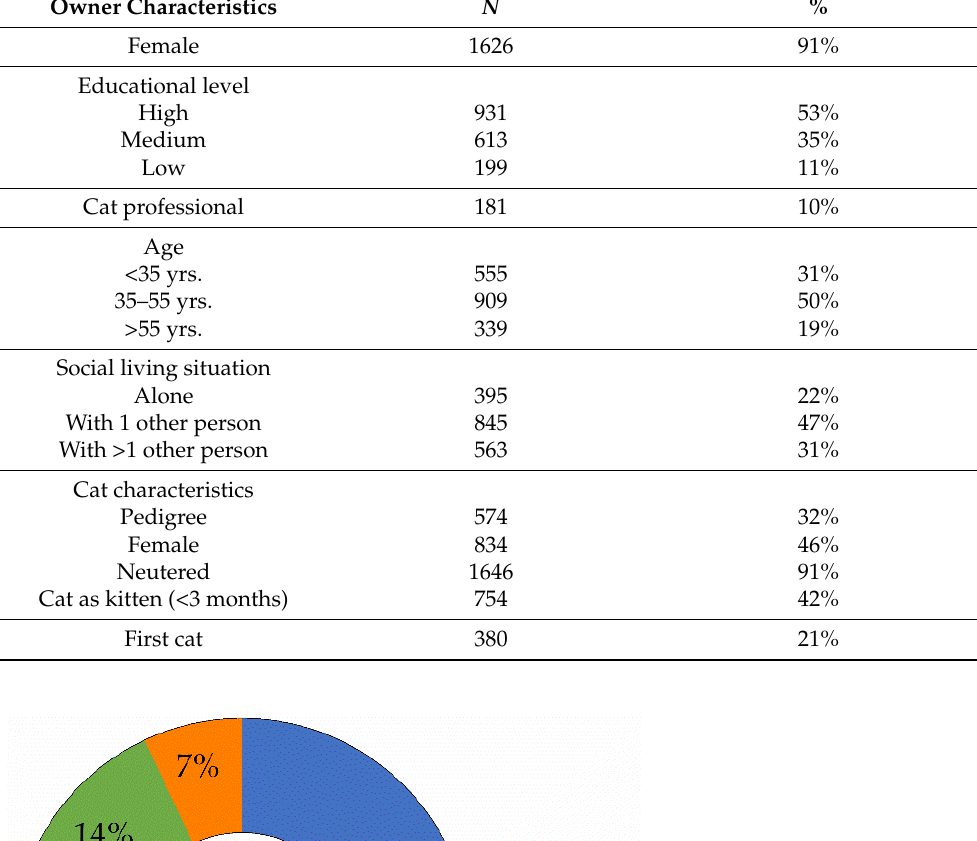
Table 1. Characteristics of owners and cats.